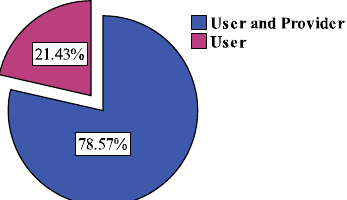
Table 2. Motivation factors for volunteer activities